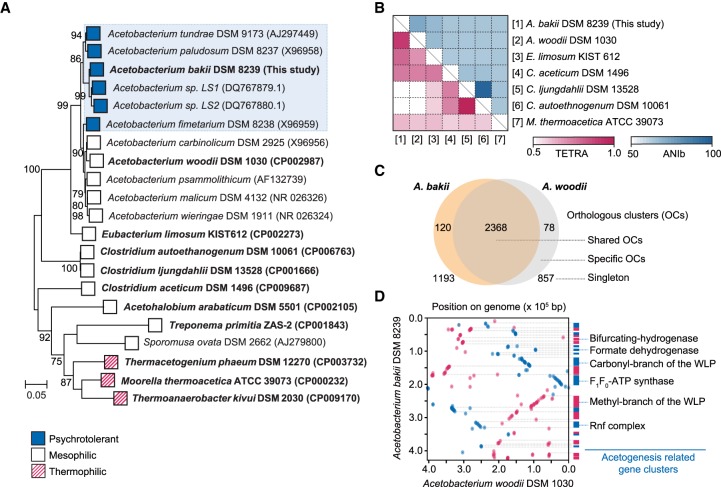
Comparative genome analysis. (A) Phylogenetic tree of the selected 21 acetogens including psychrotolerant, mesophilic, and thermophilic acetogens. Bootstrap values are shown at nodes and low bootstrap values (<70) were clipped based on 1000 trials. The maximum-likelihood phylogenetic tree was constructed in MEGA v6.06 (Tamura et al. 2013). The 16S rRNA gene sequences, obtained from genome sequence data, are shown in bold. The accession numbers for each sequence are shown after the strain name. (B) Pairwise comparison of the average nucleotide identity based on BLAST+ (ANIb) and tetranucleotide composition (TETRA) values among the available genomes of seven acetogen species analyzed via JSpeciesWS (Richter et al. 2016). Each value is shown as a row and a column with the order of species being the same on both axes. (C) Venn diagram of orthologous gene cluster between A. bakii and A. woodii. (D) An alignment plot between the A. bakii scaffold 1 and A. woodii reference genome. This plot was generated using NUCmer version 3.1 (Kurtz et al. 2004) from the MUMMER package. The syntenic blocks, representing conserved segments, were generated using Mauve alignment with default parameters (Darling et al. 2010). All the syntenic blocks were highlighted with two distinguishable colors in this dot plot.